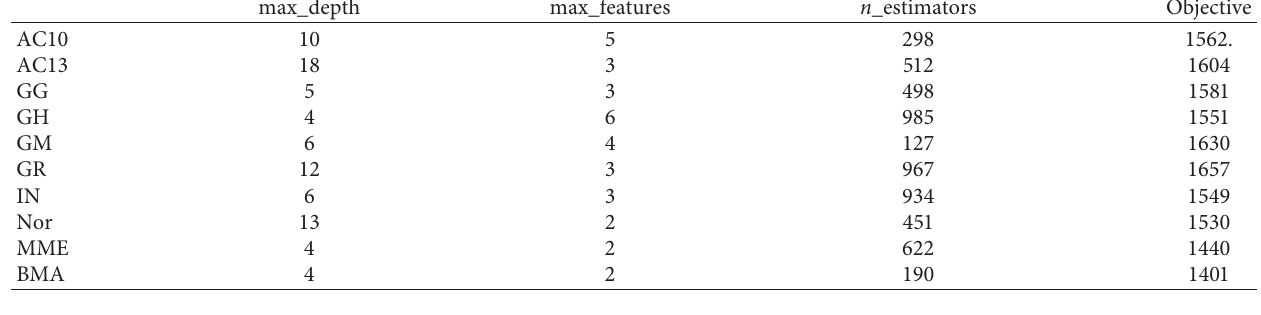
Table 10: Optimal results of Bayesian hyperparameter optimization for RF for region mean.